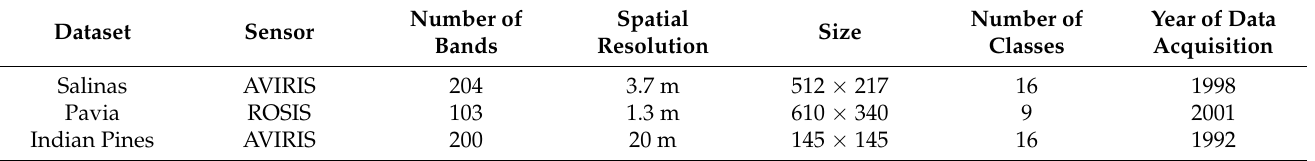
Table 1. Details of each HIS dataset.